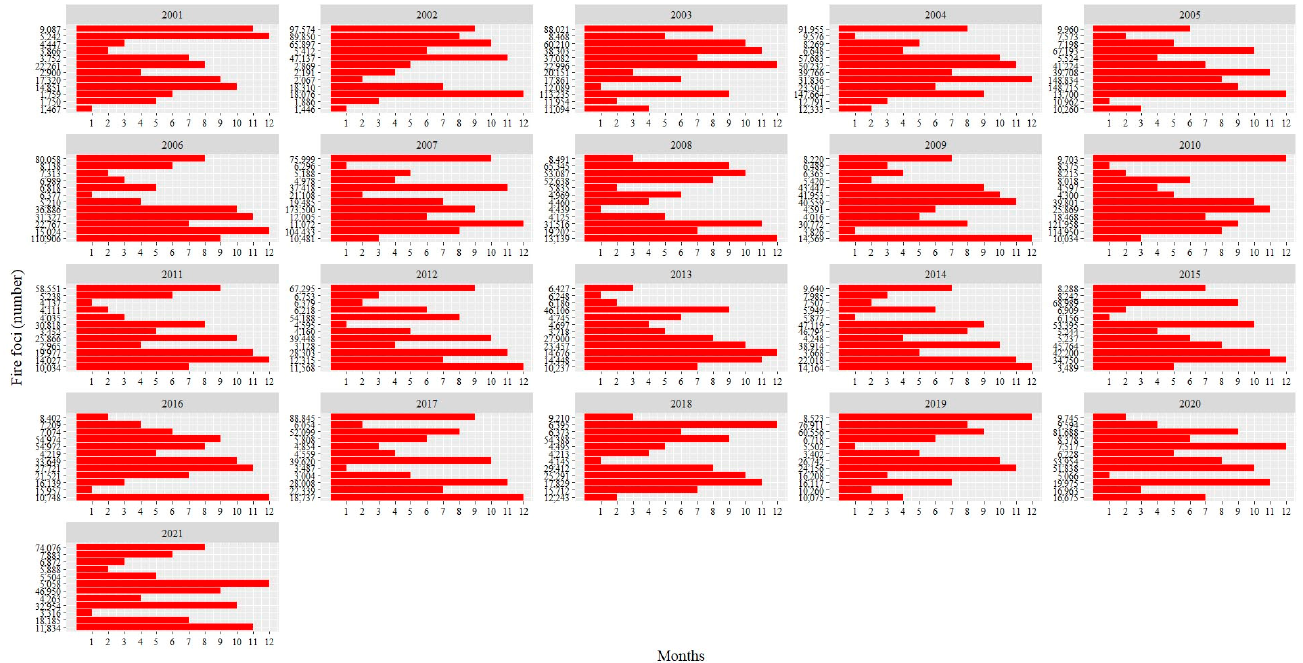
Figure 2. Temporal distribution of fire foci in the tropical and subtropical longleaf forest biome of South America in the 2001–2021 series.